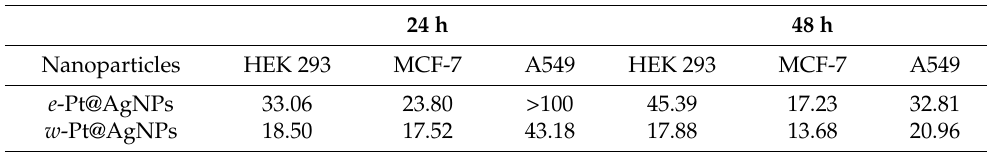
Table 3. The calculated IC 50 values ( µ g/mL) for e -Pt@AgNPs and w -Pt@AgNPs in HEK 293, MCF-7, and A549 cells incubated for 24 h and 48